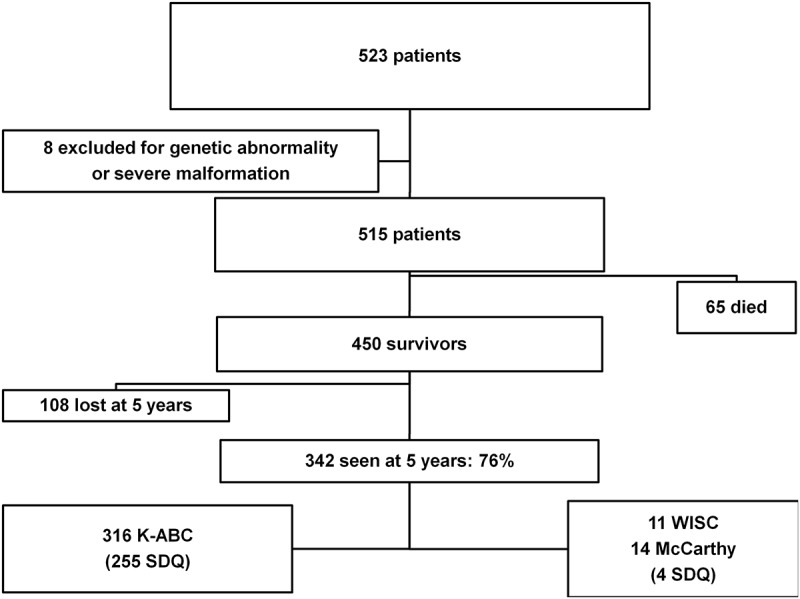
Flow chart of the study population.